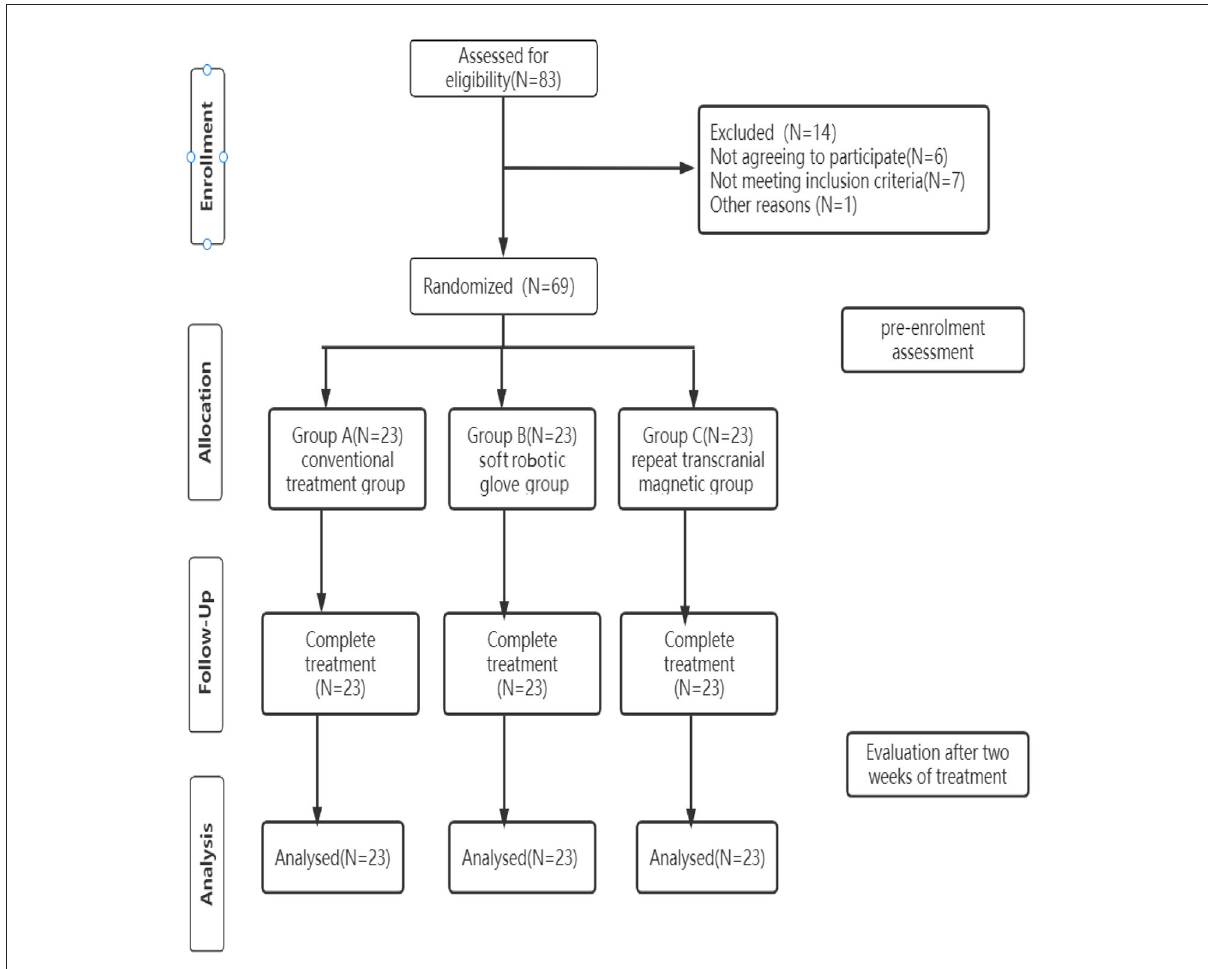
FIGURE1 Flowchart of the experimental